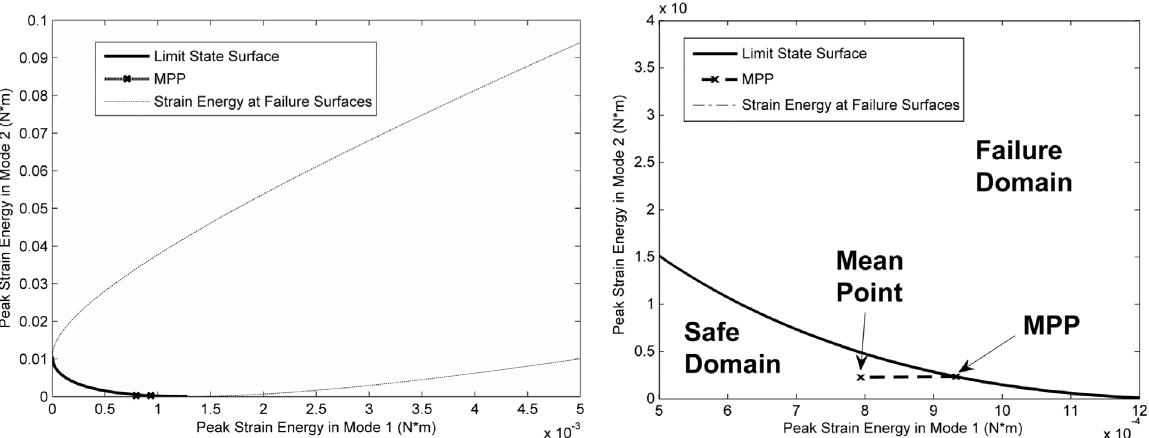
Fig. 5. Limit state surface, strain energy at failure surfaces, and MPP for failure of spring 2 in structure 1 with Z 3 = Z ∗ 3 and Z 4 = Z ∗ 4 .